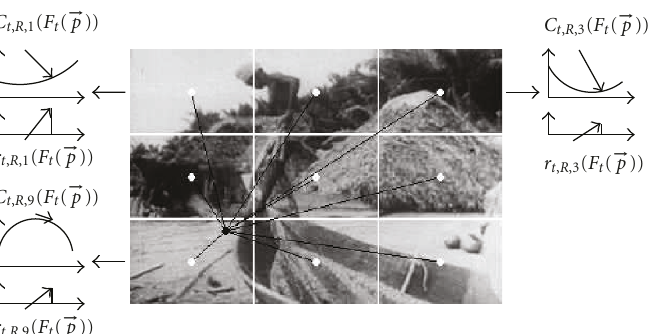
Figure 7: Block-based partition of the first frame of Boat using a 3 × 3 grid. The pixel undergoing compensation and the centre of each block are represented by black and white dots, respectively. The black lines represent the Euclidean distances c b ( p ). Polynomial correction profiles C t ,ref, b and associated reliabilities r t ,ref, b are available for each block b . Compensation value for pixel (cid:2) p is obtainted by a bilinear interpolation of the block-based compensation values (9 in this example). Bilinear interpolation involves weighting by block-based reliabilities and distances d b .